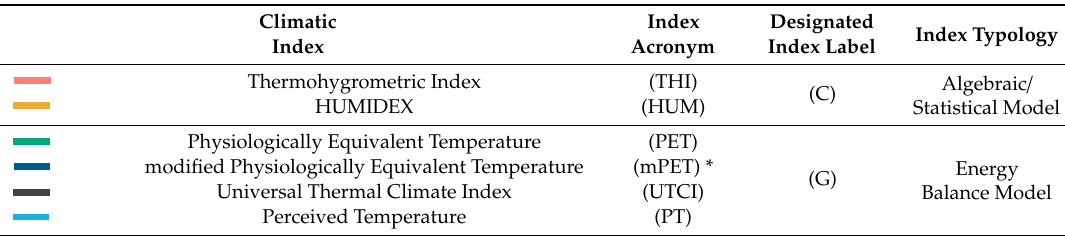
Table 3. Identification of utilized indices and their respective ‘Primary’ used in the study against their index model typology. * Added to ‘G’ category based upon its close association to the MEMI model.